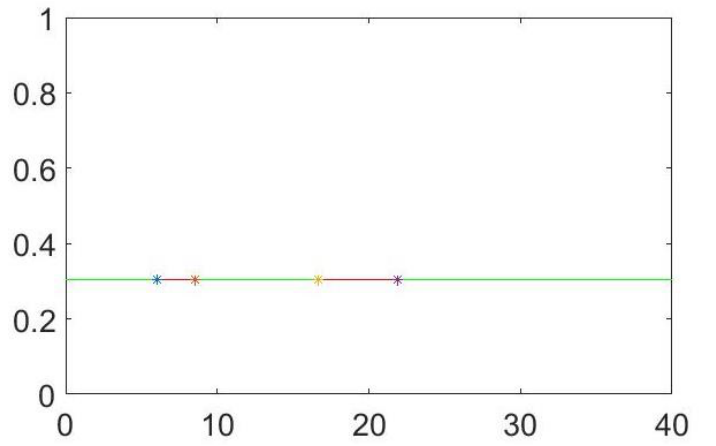
Figure 11. Time delay parameter, τ ∗ at E 1 = ( 0.1,0.39,2.62, 11.41 ) . Green line represents stable and red line represents unstable,